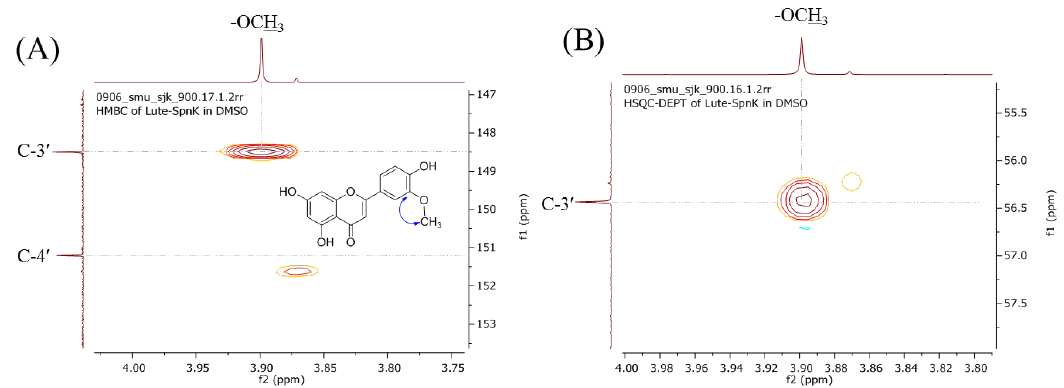
Figure 4. Zoomed-in view of ( A ) HMBC and ( B ) HSQC-DEPT analyses of chrysoeriol. The cross peak shows the correlation of the proton of methoxy-carbon with C- 3′ of the benzene ring in HMBC. The carbon of the methyl group attached at C3’ -OH.